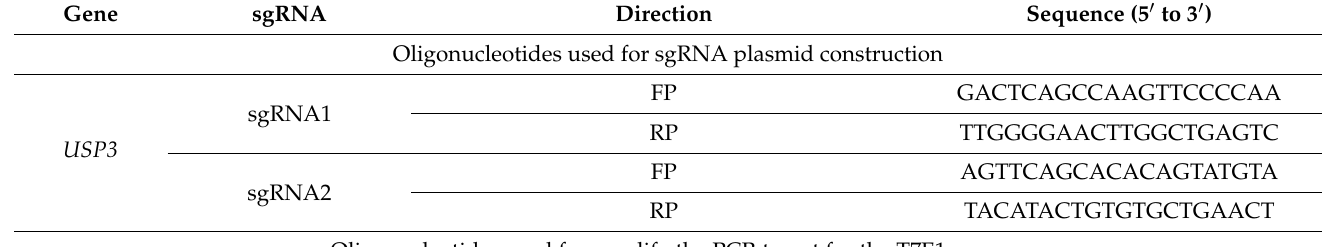
Table 1. Oligonucleotides used in this study.